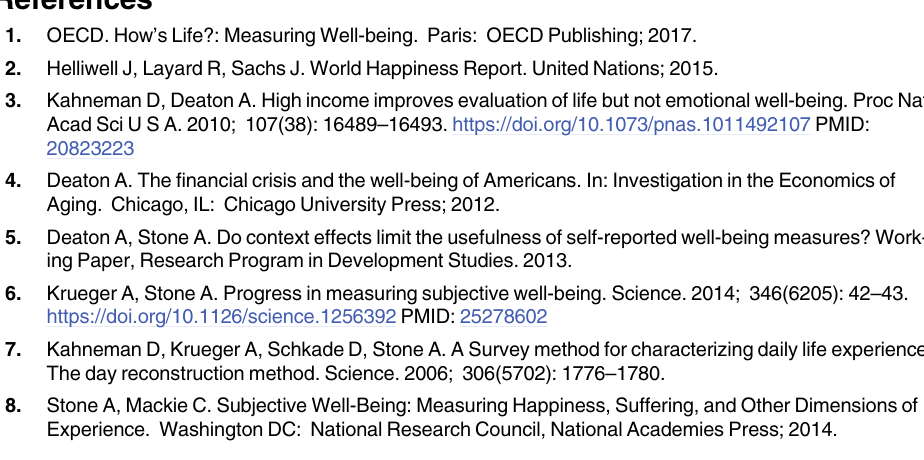
S1 Table. Category components. S2 Table. Bayesian model averaging